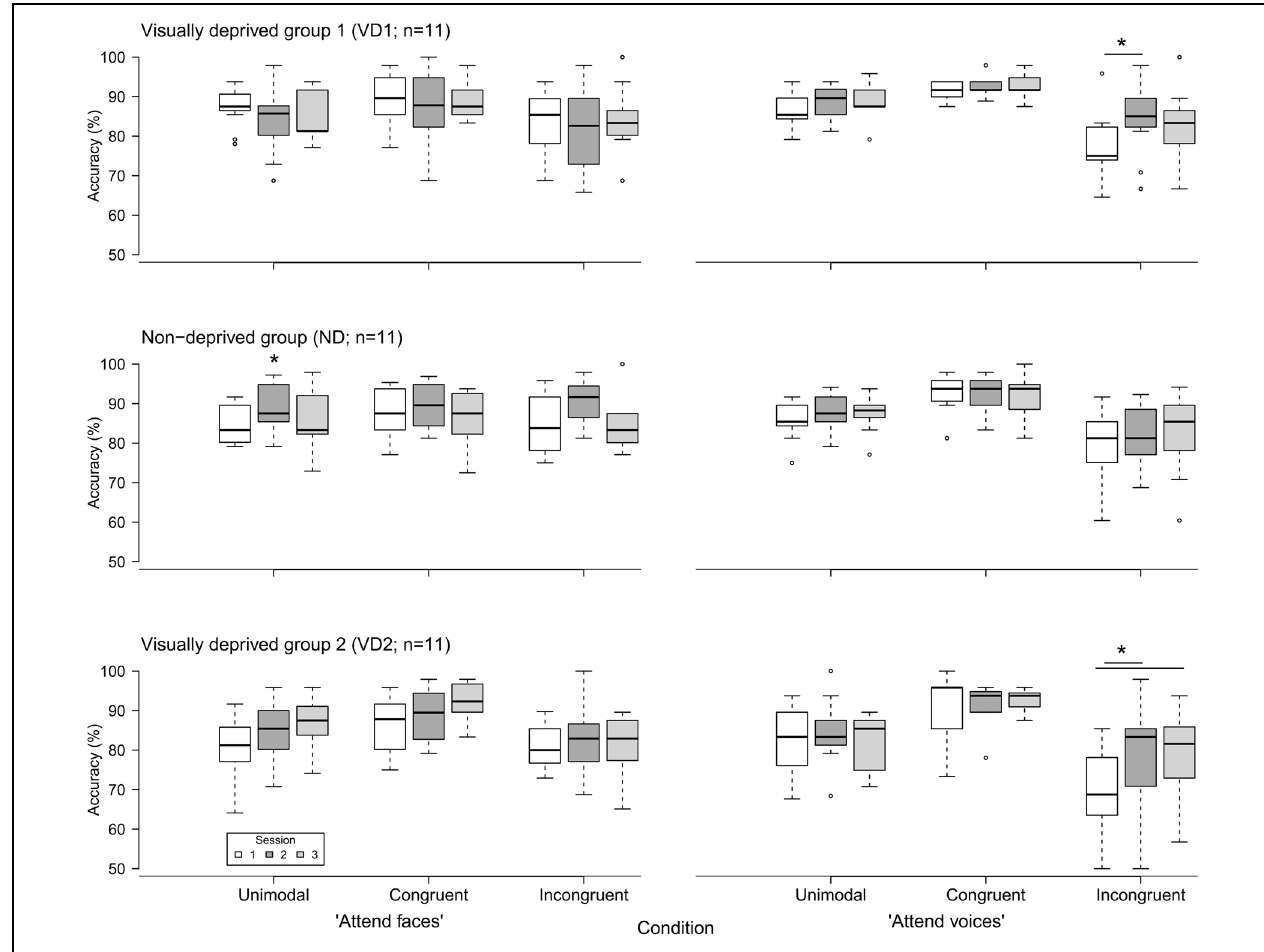
FIGURE 2 | Accuracy of emotion discrimination (in percent) in the three groups (VD1, ND, VD2; n = 11 each) as a function of session (1, 2, and 3), block (“attend faces,” “attend voices”), and condition (unimodal, congruent, incongruent). Whiskers denote the lowest and highest data